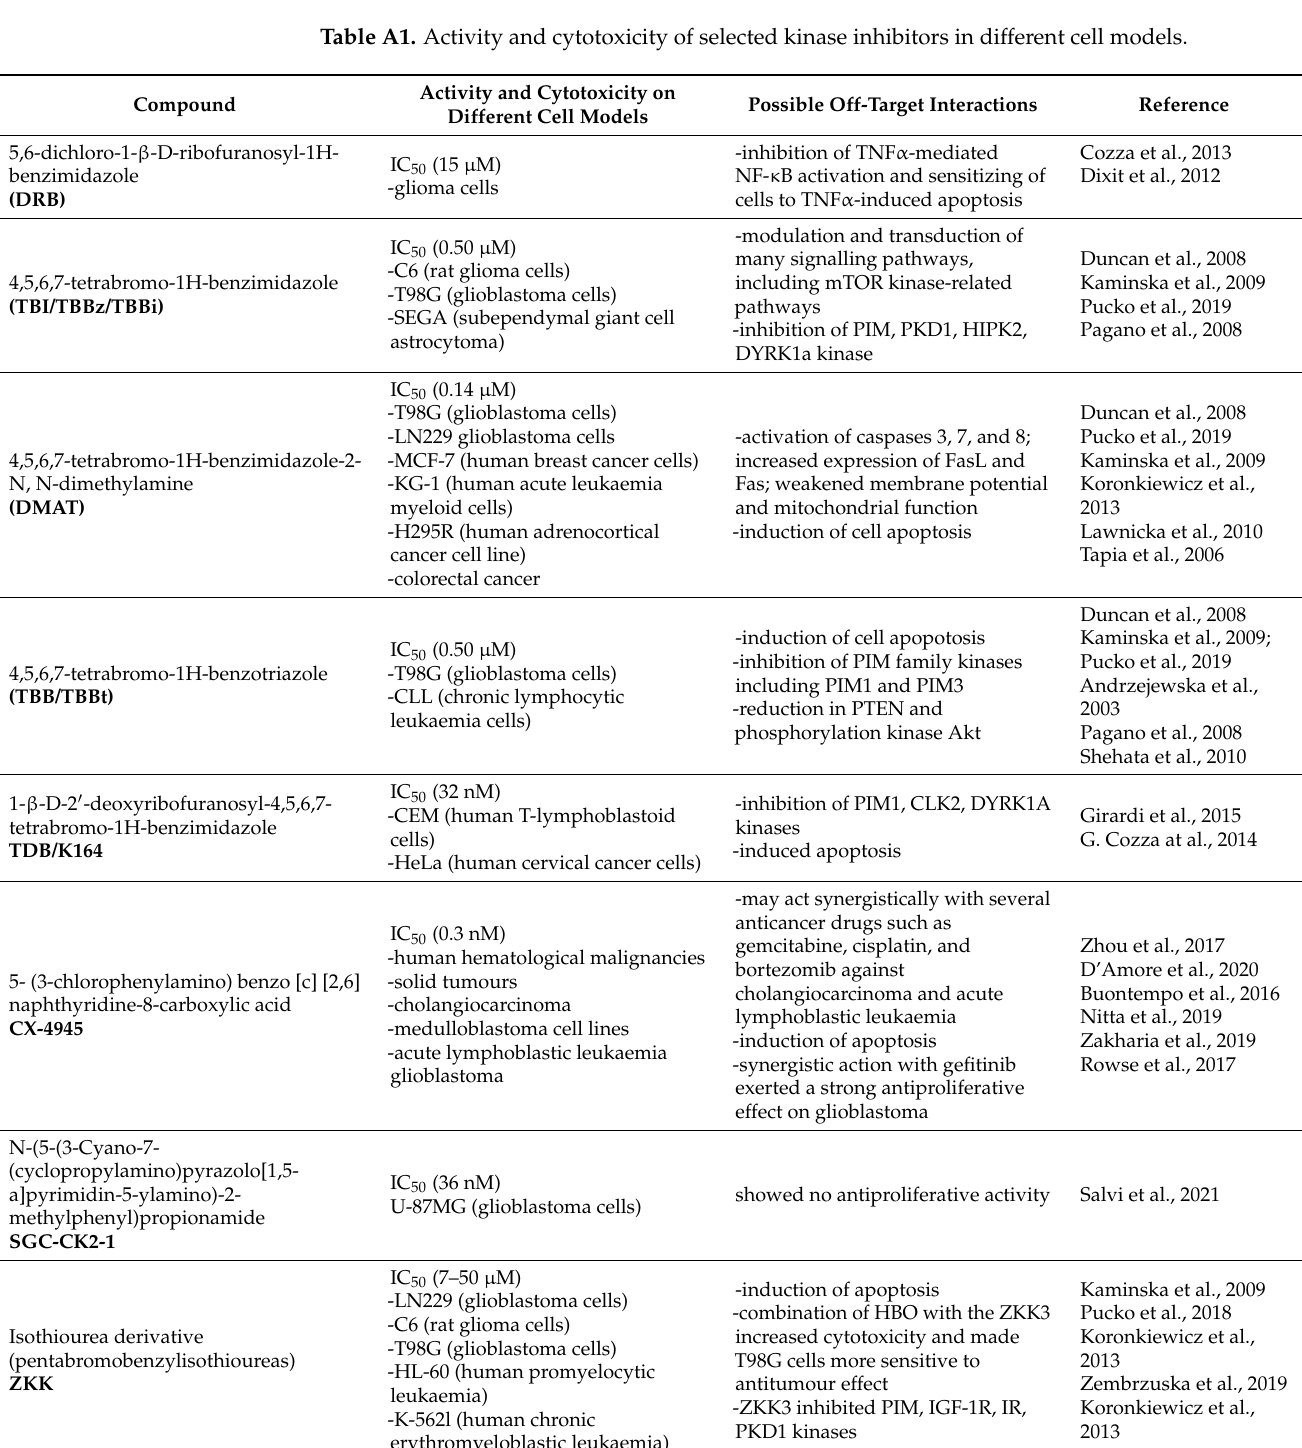
Table A1. Activity and cytotoxicity of selected kinase inhibitors in different cell